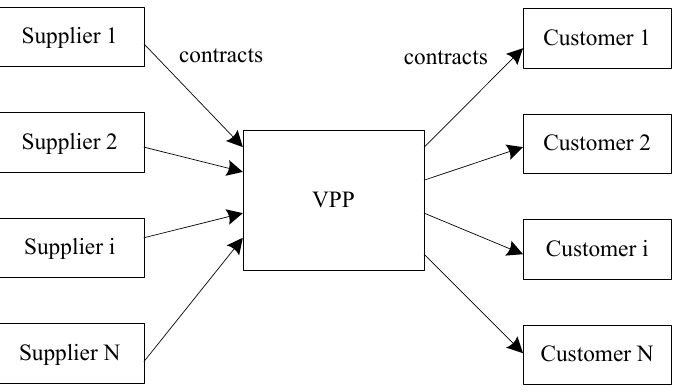
Figure 2. Electric power supply chain of